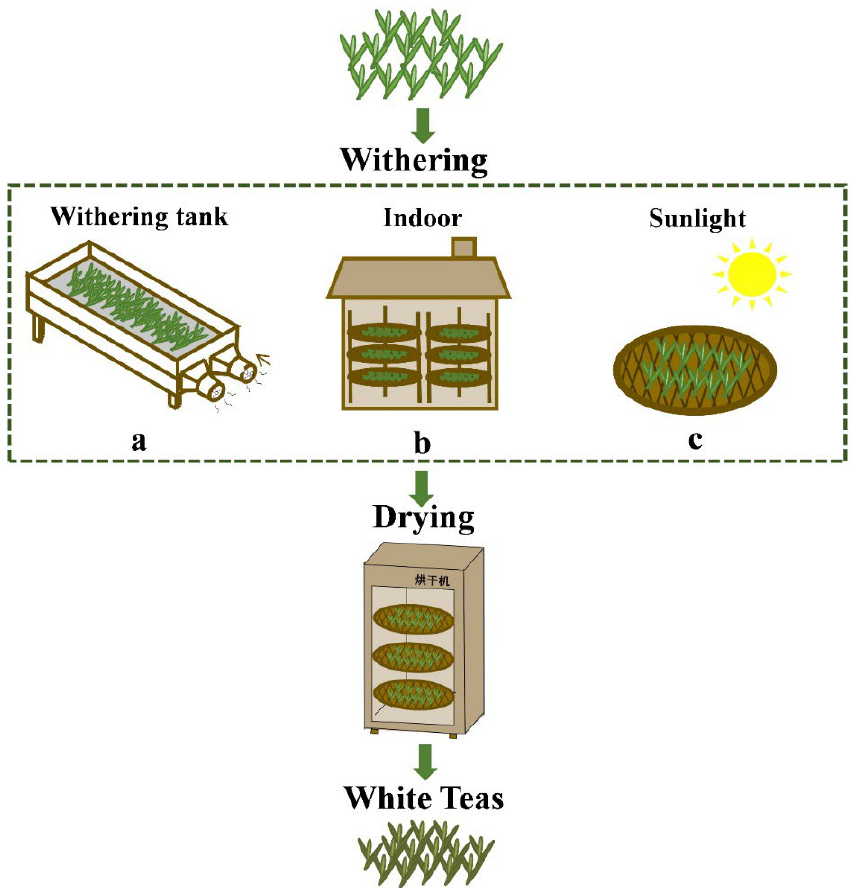
Figure 1. White tea processing flowchart. ( a ) Withering-tank treatment, ( b ) indoor treatment, and ( c ) sunlight treatment.